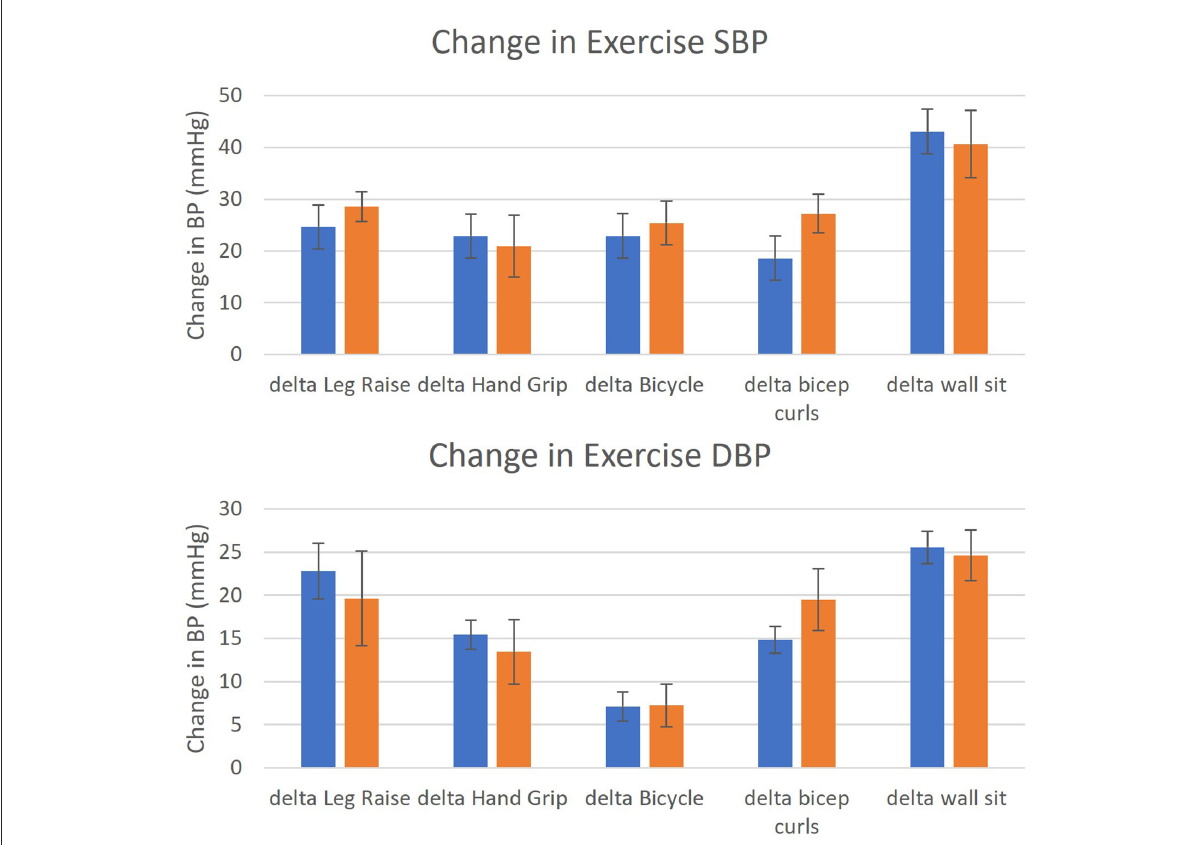
FIGURE1 Mean change in exercise systolic blood pressure (SBP) and diastolic blood pressure (DBP) from baseline in TAD ( n = 31) and controls ( n = 14). Legend: TAD (blue); controls (orange). Y-axis: change in blood pressure during activity (mmHg); x-axis: as labeled, error bars: one standard error. Differences in SBP and DBP between TAD and controls were assessed with 2-tailed Student t tests with appropriate degrees of